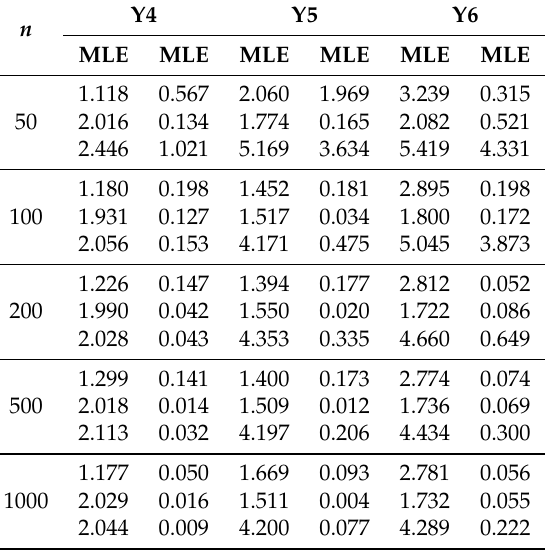
Table 6. Simulation study for the EMIEE model: MLEs and MSEs with the following sets of parameters: Υ 4( α = 1.2, β = 2.0, γ = 2.0), Υ 5( α = 1.8, β = 1.5, γ = 4.0), and Υ 6( α = 3.0, β = 1.5, γ = 4.0).